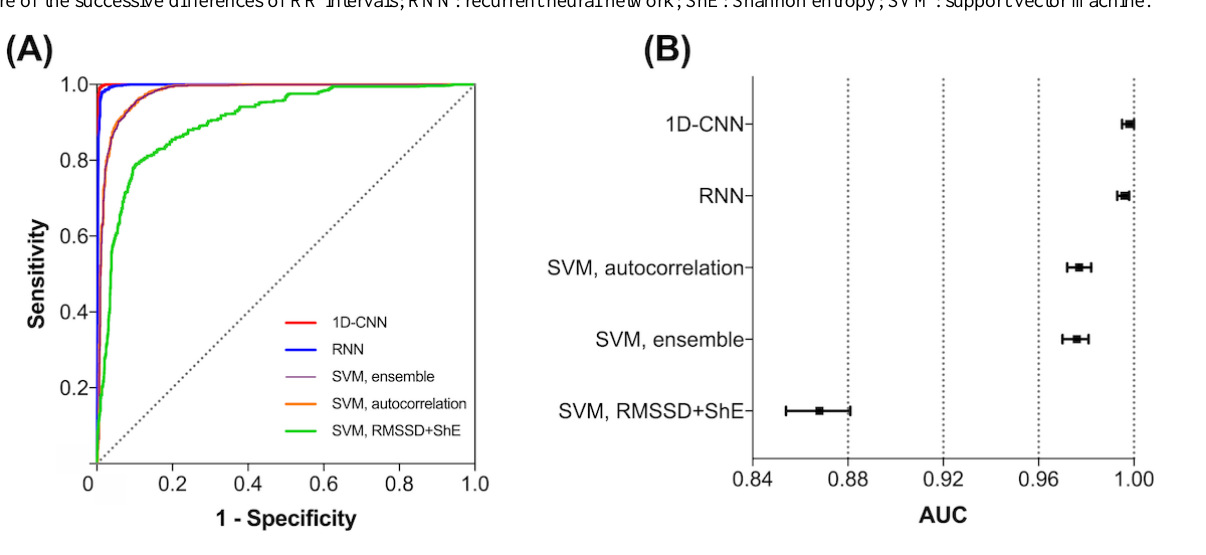
Figure 3. The receiver operating characteristic (ROC) curves of 2 deep learning classifiers (1-dimensional convolutional neural network, 1D-CNN and recurrent neural network, RNN) compared with other previous high-end atrial fibrillation (AF) detectors. (A) A Comparison of several ROC curves by different AF-detection algorithms. (B) The area under the curve and corresponding 95% CI by different algorithms. Both 1D-CNN and RNN methods showed significantly better diagnostic performance than previous detectors. 1D-CNN: 1-dimensional convolutional neural network; RMSSD: root-mean square of the successive differences of RR intervals; RNN: recurrent neural network; ShE: Shannon entropy; SVM: support vector machine.